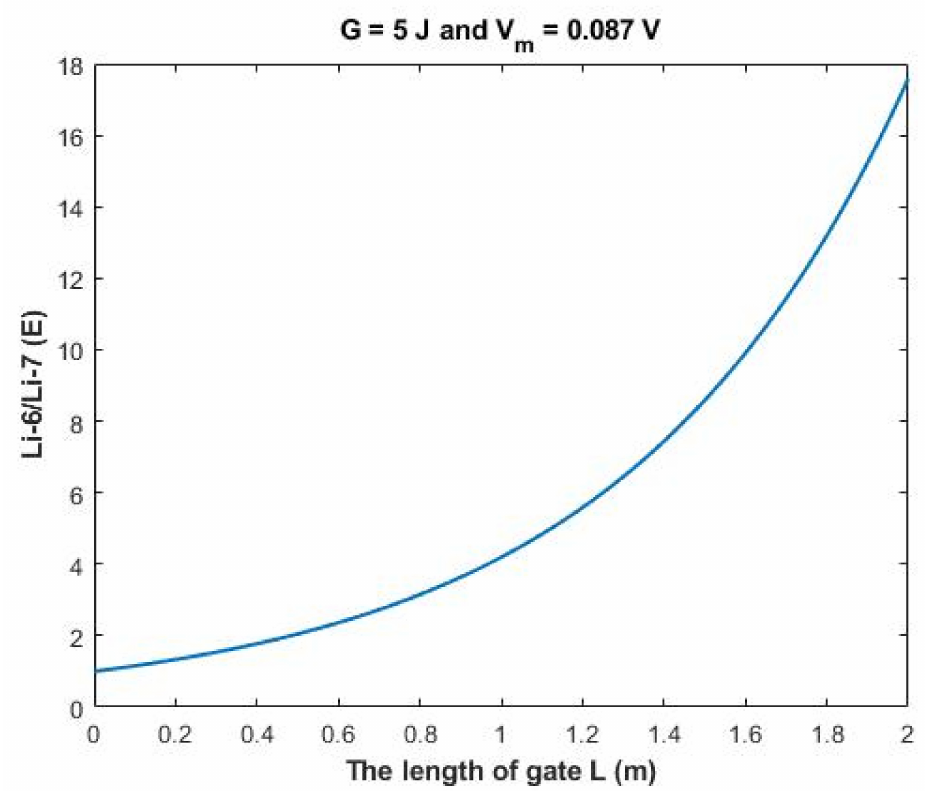
Figure 13. The figure represents the relationship between the ratio of the extracellular lithium isotopes Li-6/Li-7 ( E ) and the length of gate L when setting G = 5 J and V m = 0.087 V. Table 33. The table shows the ratio Li-6/Li-7 ( E ) that can take the range between the two values at L = 0 m and at L = 2 m and shows the rate of change in the ratio with respect to the length of gate L . Li-6/Li-7 ( E ) at L = 0 m Li-6/Li-7 ( E ) at L = 2 m Rate of Change A(L) 1 17.57 8.29 m −